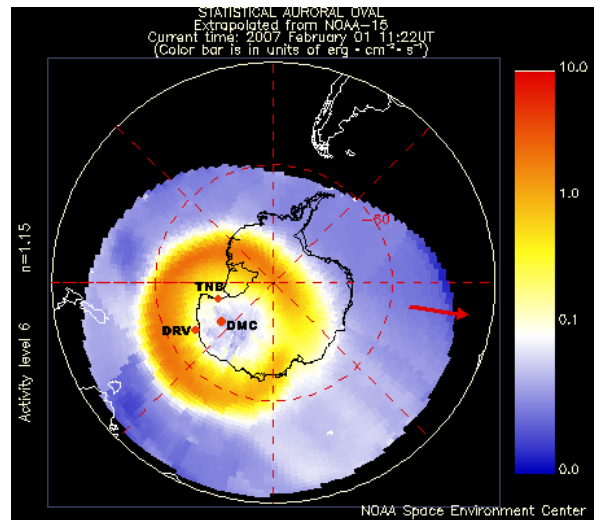
Fig. 1. Current extent and position of the auroral oval in the Southern Hemisphere, extrapolated from measurements taken dur- Figure 1. Current extent and position of the auroral oval in the southern hemisphere, ing a recent polar pass of the NOAA POES satellite (from http: extrapolated from measurements taken during a recent polar pass of the NOAA POES satellite //www.sec.noaa.gov). The position of DMC, TNB and DRV obser- (from http://www.sec.noaa.gov). The position of DMC, TNB and DRV observatories is also vatories is also reported.